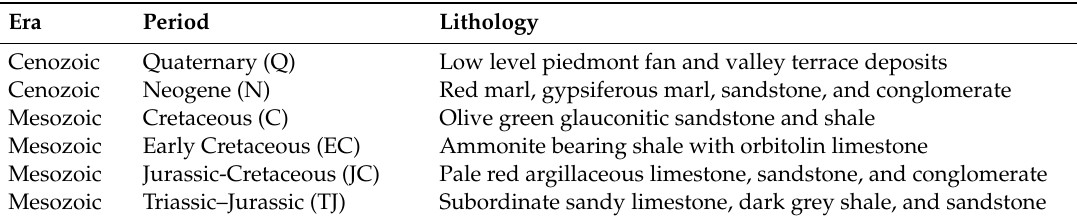
Table 3. Lithology of the study